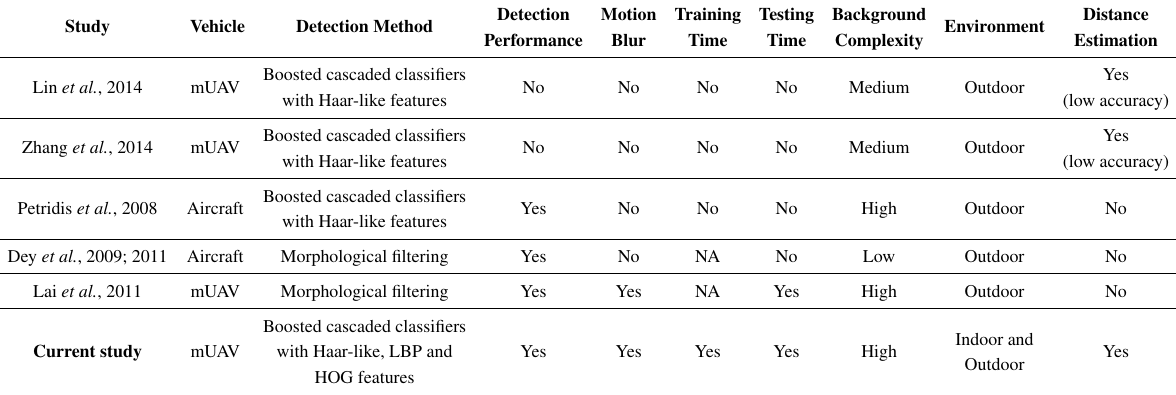
Table 1. Comparison of the studies on the visual detection of aerial